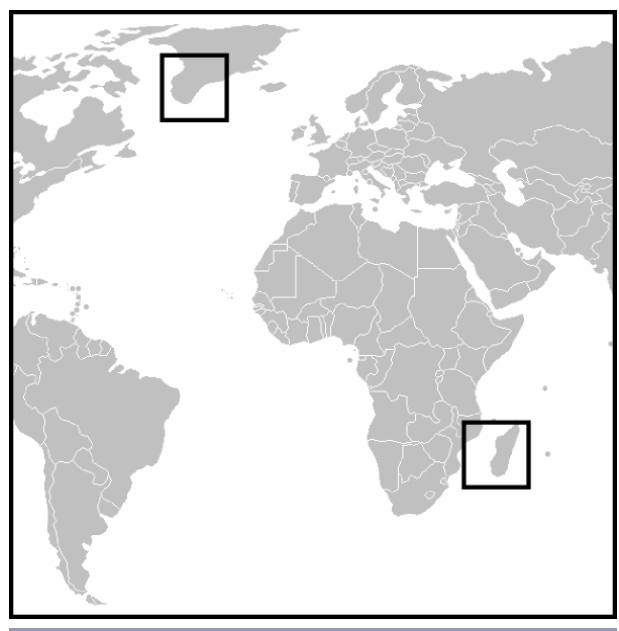
Fig. 1 . The two social-ecological case studies: Greenland between late AD 900 and mid-1400 and contemporary Androy,